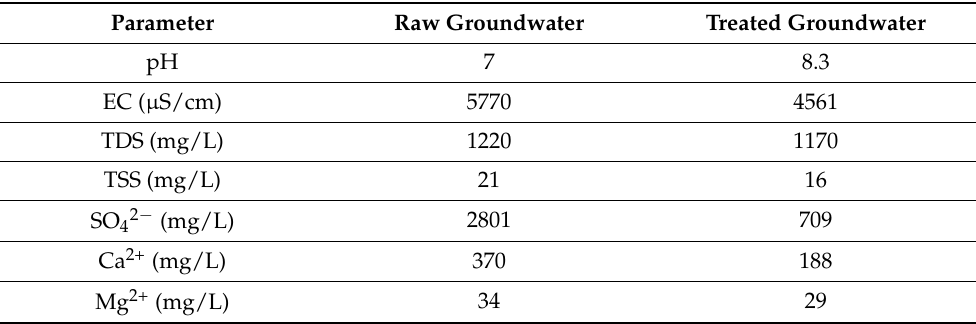
Table 3. Values of popular characteristics for real groundwater samples before and after interaction with composited sorbent prepared in this work in column mode